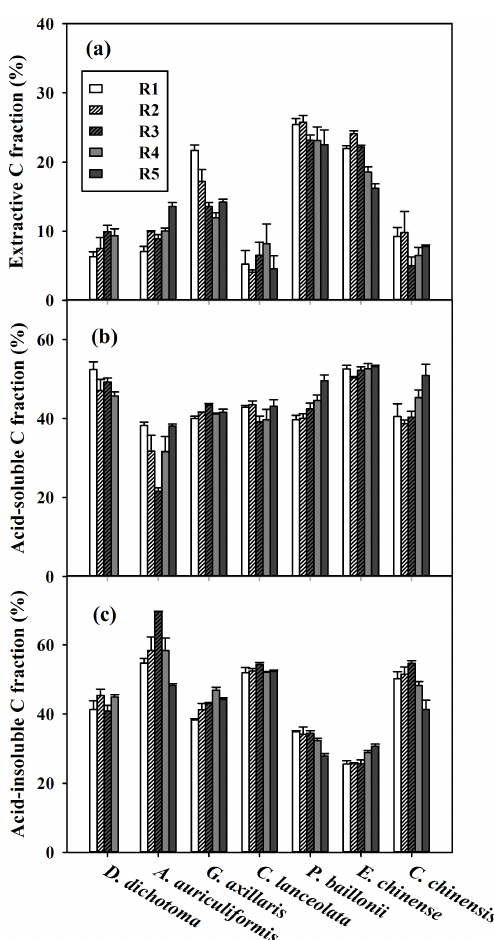
Figure 5. The extractive C fraction (a) , acid-soluble C fraction (b) and acid-insoluble C fraction (c) for the first five root orders for each of seven plant species. R1–R5 refer to the first to fifth order.